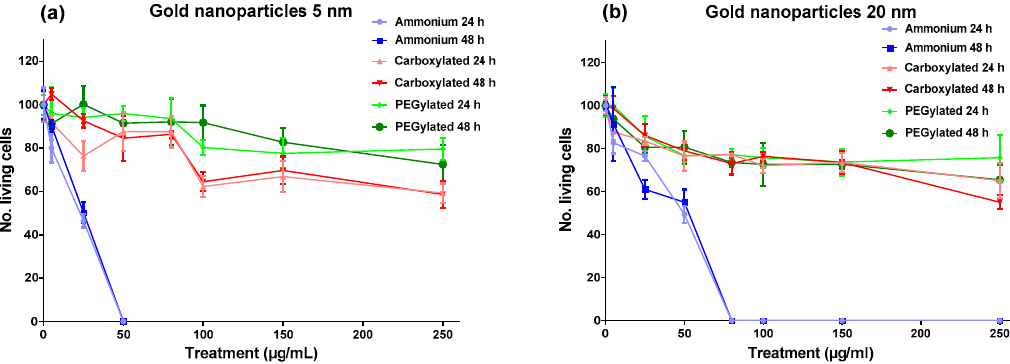
Figure 1. Number of living cells relative (%) to untreated control cultures after treatment of BEAS-2B cells with gold nanoparticles (core diameter: ~5 nm ( a ) or ~20 nm ( b )) for 24 or 48 h. Dead cells were identified by trypan blue staining. The symbols represent means ± SD.